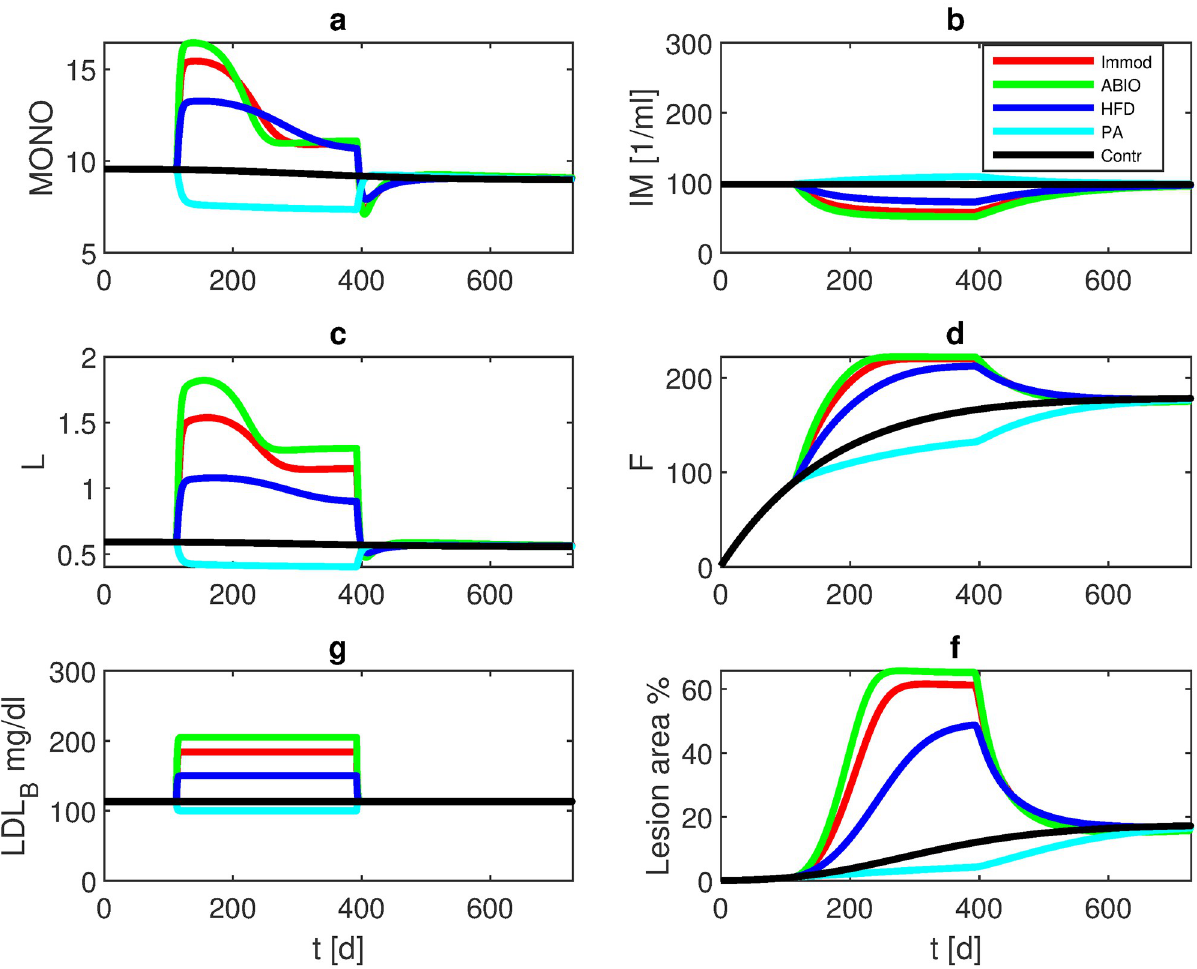
Fig 10. Regeneration after stopping interventions. We simulated mice with normal diet and without medication until week 16. From week 16 until week 56, HFD, immune modulation, antibiotics, or PA are given, followed by normal diet without therapy again. The curves represent model results of a) monocytes in plaque, b) macrophages in plaque, c) LDL-C in plaque, d) foam cells, e) LDL-C in blood, and f) lesion area. It revealed that the interventions are reversible, i.e. the system returns to the trajectory of the control